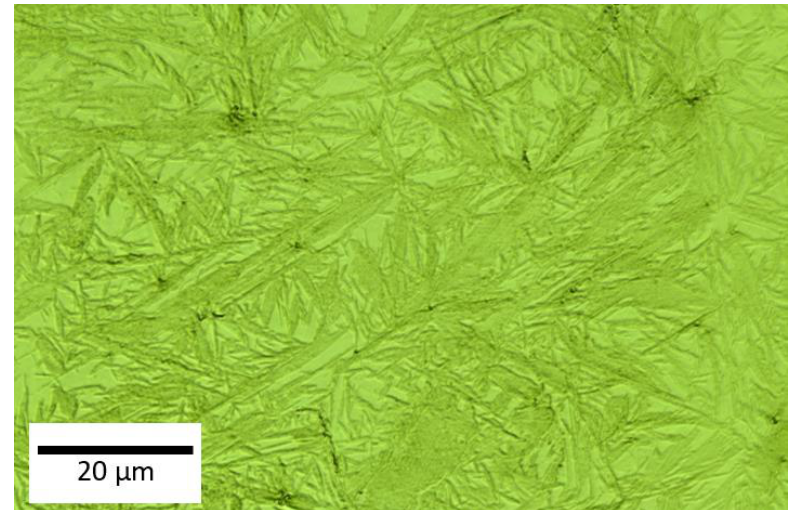
Figure 2. 3D images of the starting sample surface without corrosion.